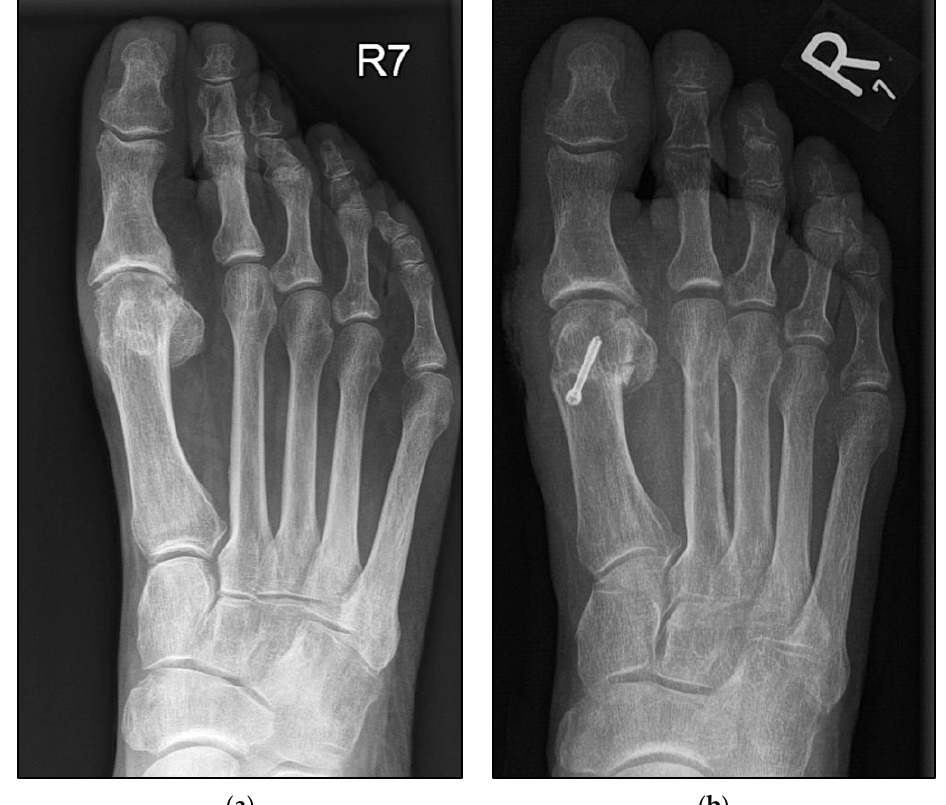
Figure 4. Pre- and postoperative radiographic findings of combined Weil osteotomy of metatarsal 2 (group B without screw) and hallux valgus surgery, left foot. ( a ) Anteroposterior view preoperative, ( b ) anteroposterior view 6 weeks postoperative.